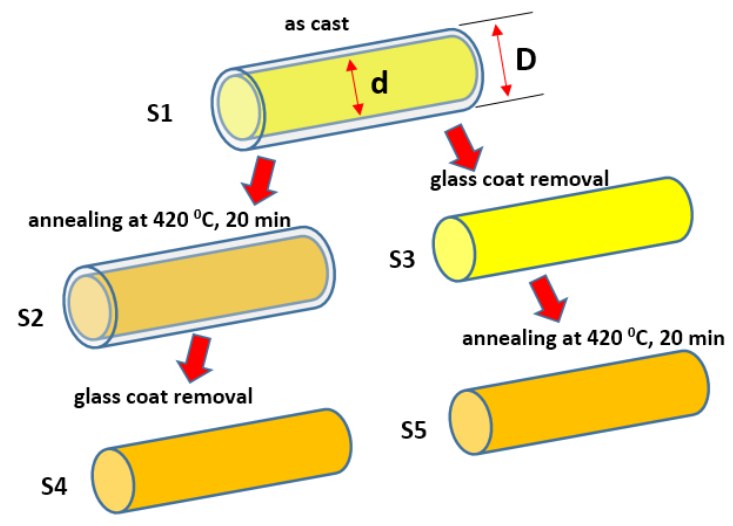
Figure 2. Preparation scheme for microwires.